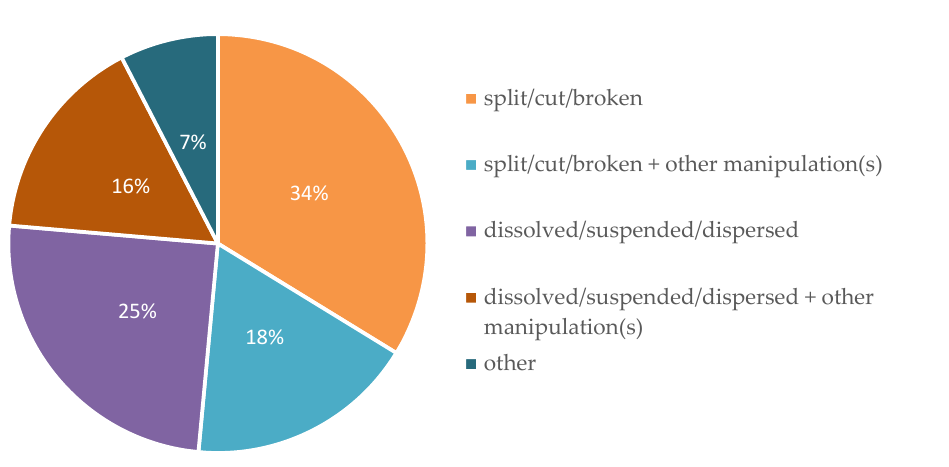
Figure 3. All manipulations observed classified by the type of manipulation.